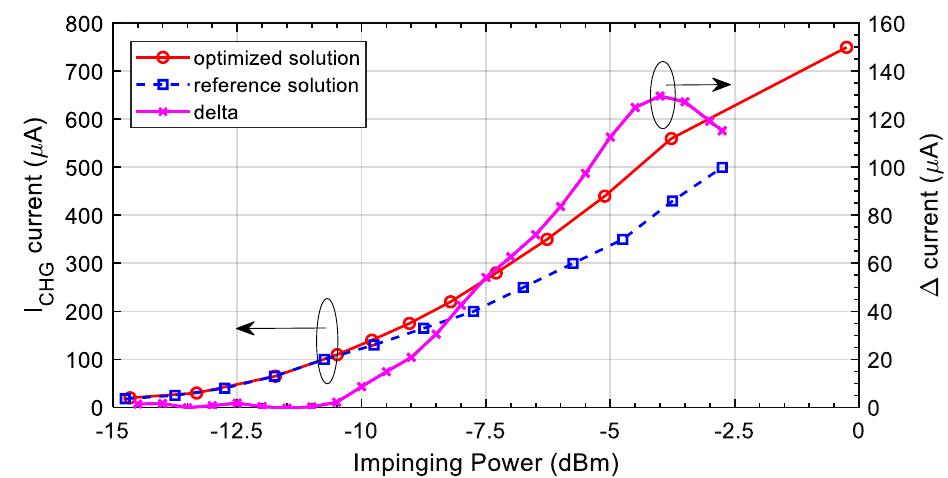
Figure 14. Measured charge current 𝐼 𝐶𝐺𝐻 versus the impinging power.